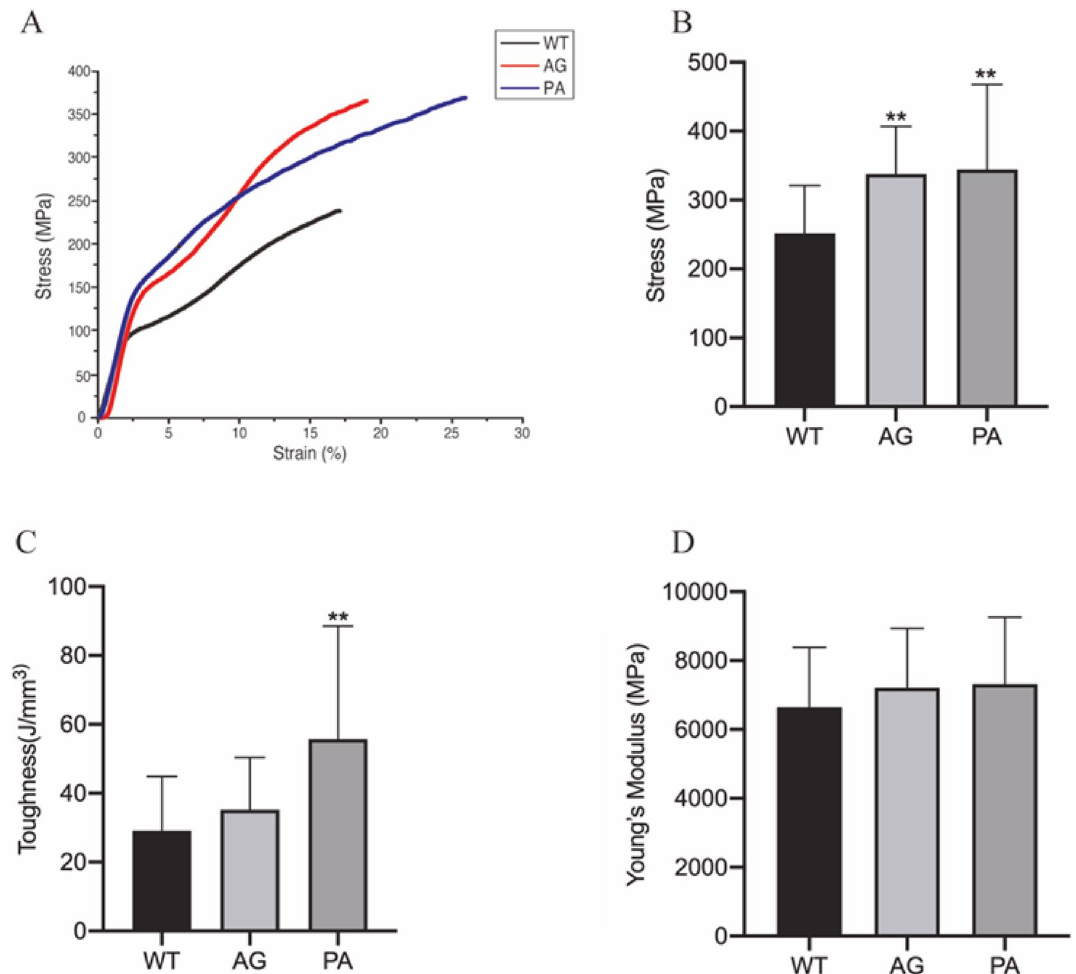
Figure 6. Mechanical properties of the recombined spider silk fibers from the PA and AG strains. ( A ) Stress– strain curves of WT and FibH-spider silk fibers, which were tested at a speed of 2 mm/min under equivalent conditions. The result for the WT fiber is shown in black, and the lines in red and blue indicate the results for the AG and PA strains, respectively. Fifty samples from each transgenic strain were tested. ( B – D ) Graphs of the maximum stress, toughness and Young’s modulus, respectively. The significance of the difference between transgenic fibers and WT was calculated using two-tailed Student’s t-tests. *P < 0.05; **P < 0.01. WT AG PA Ave. SD Ave. SD %